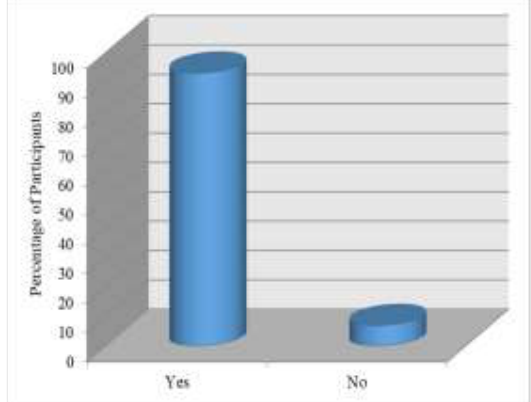
Figure 2. Percentage of participants using the internet during working hours in the pharmacy to find a specific information for certain drug.